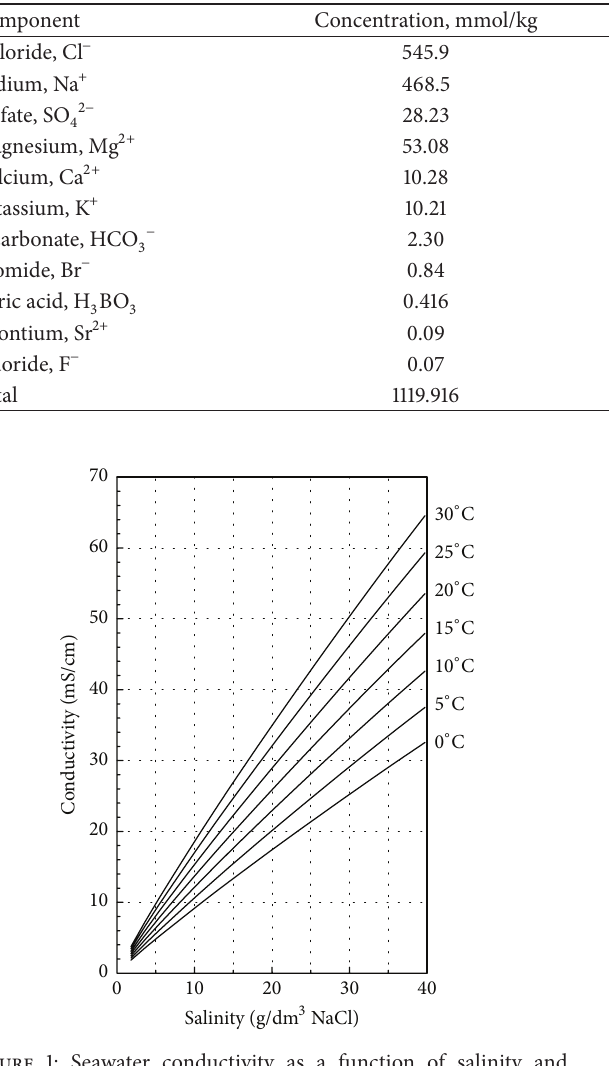
Figure 1: Seawater conductivity as a function of salinity and temperature, based on data in [2].